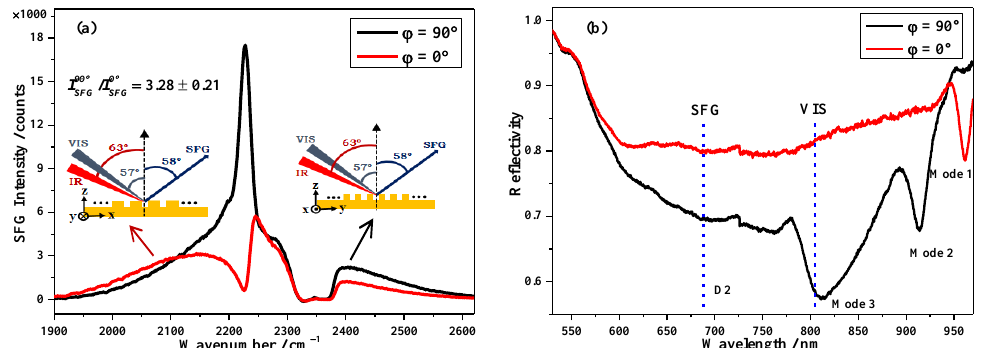
Figure 5. ( a ) SFG spectra of 4-Mercaptobenzonitrile (4-MBN) on Au NHAs with different structural orientation angles (with 1 mW VIS, 5 mW IR, and 60 s acquisition time). Insets are the SFG optical configurations. ( b ) Structural orientation dependent reflectance spectra of Au NHAs at a 57.4° incident angle.